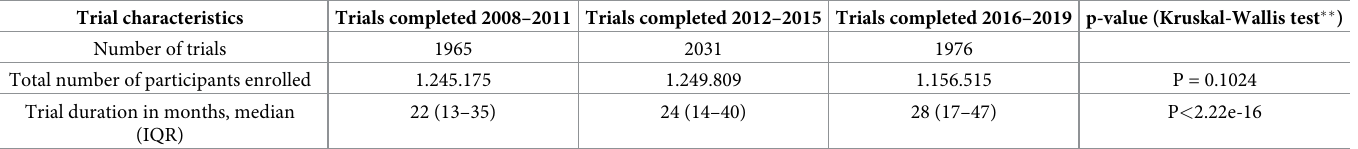
Table 1. Basic characteristics of industry-sponsored phase III trials conducted during 2008–2019. Over time development of number of trials, number of participants enrolled and trial duration in months are presented in the table together with corresponding p-values. Trial